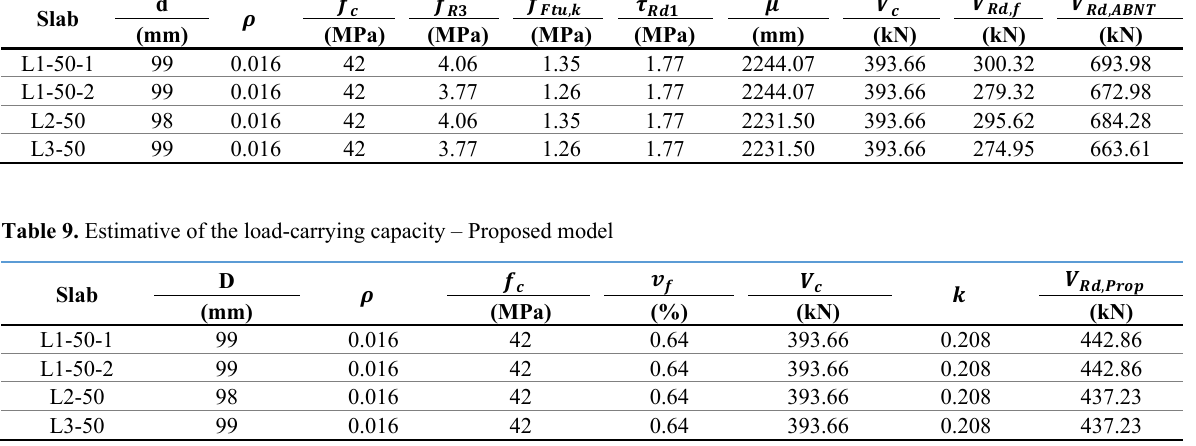
Table 8. Estimative of the load-carrying capacity – ABNT NBR 16935 (2021) [12] Slab